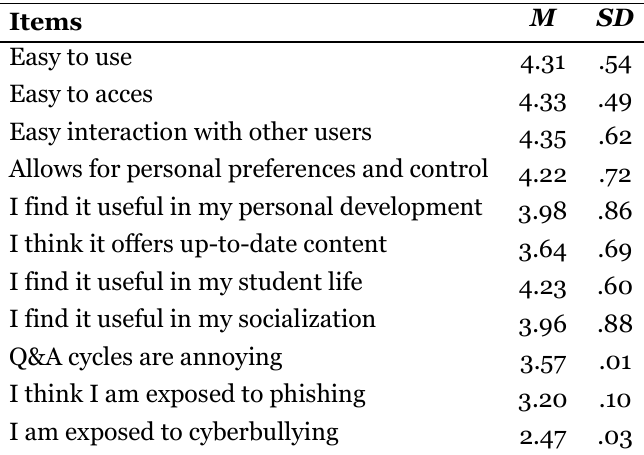
The PLE Perception Scale Means and Standard